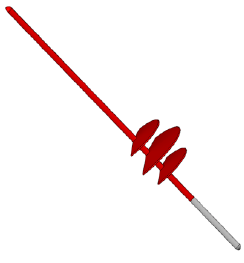
Figure 1. The high voltage end simplified model of composite insulator.